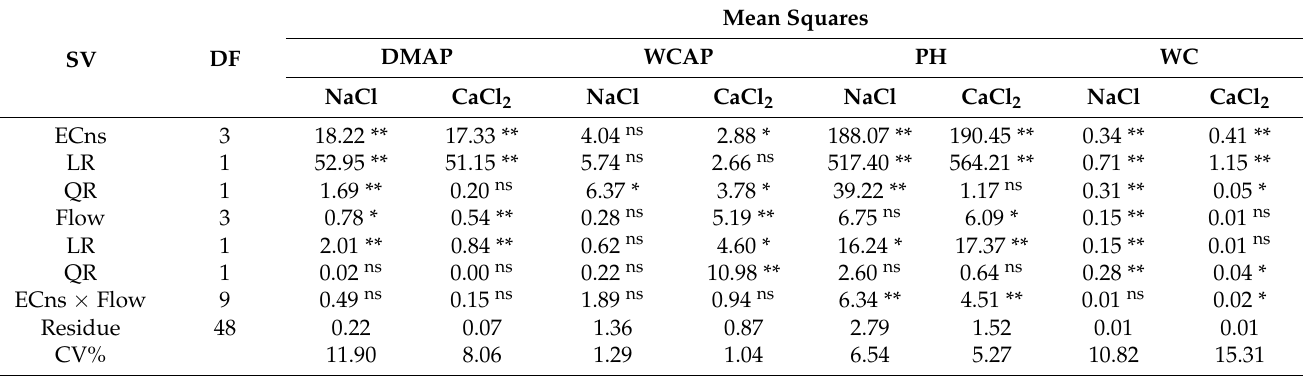
Table 2. Mean squares (MS) analysis of variance (ANOVA) for dry mass of aerial part (DMAP), water content in aerial part (WCAP), plant height (PH), and water consumption (WC) of coriander plants, cv. Verd ã o, exposed to different levels of electrical conductivity and nutrient solution flow rate under cationic prevalence of NaCl and CaCl2 ·